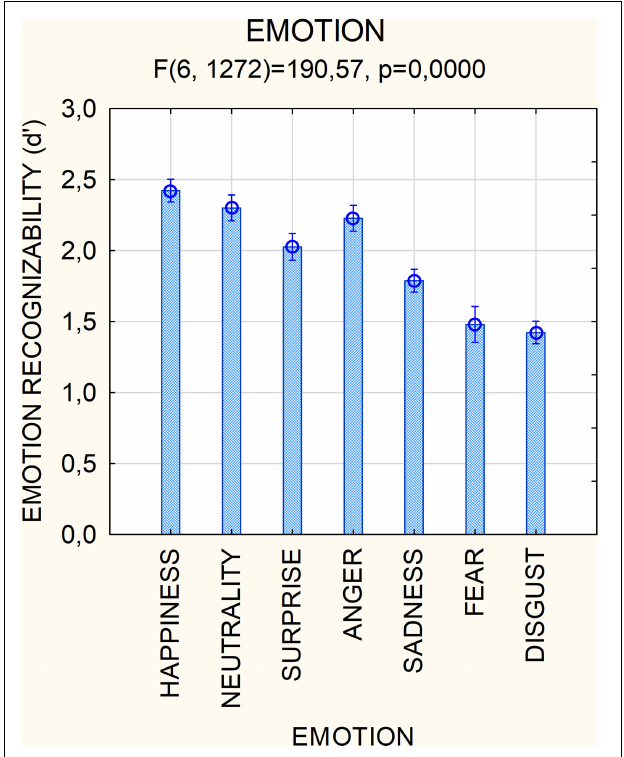
FIGURE 2 | Mean scores of recognizability (along with SE values) attributed by participants ( N = 214) to the various facial expressions regardless of masking condition. Scale ranged from 0 = “not much recognizable” to 3 = “very well recognizable”.